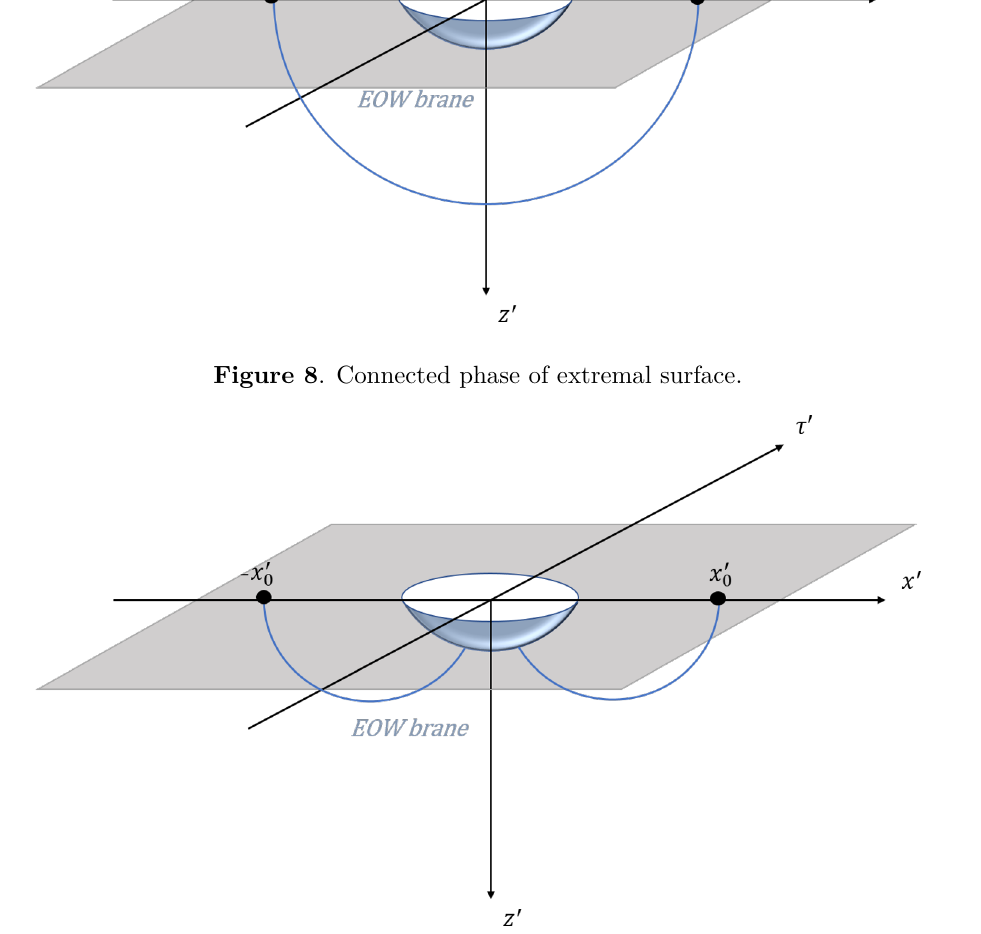
Figure 9 . Disconnected phase of extremal